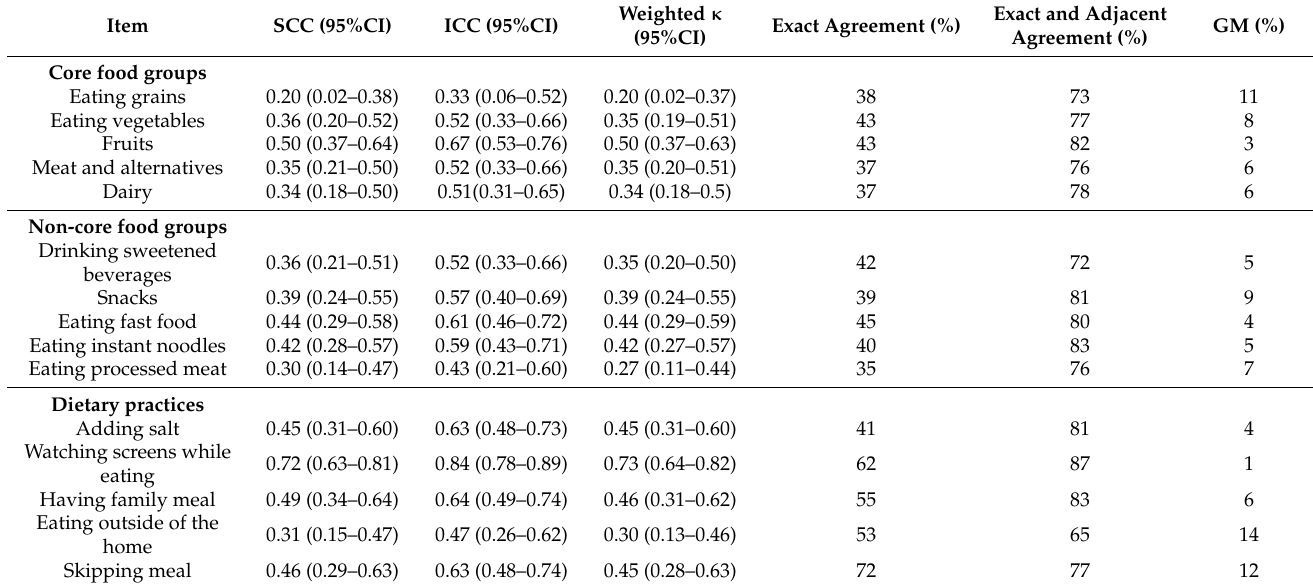
Table 4. Reproducibility of the VCSDQ ( n =